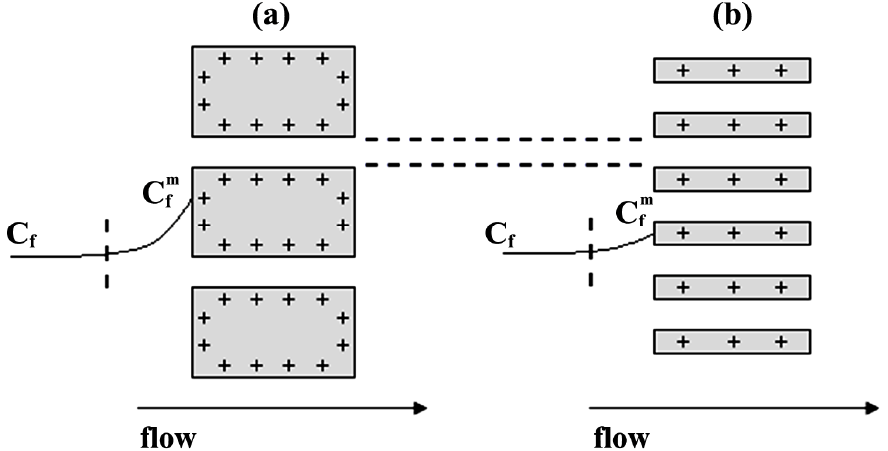
Figure 6. Schematic representation of solution concentration profiles near membranes with similar pore size and: ( a ) high fixed charge and low porosity; and ( b ) low fixed charge and high porosity.